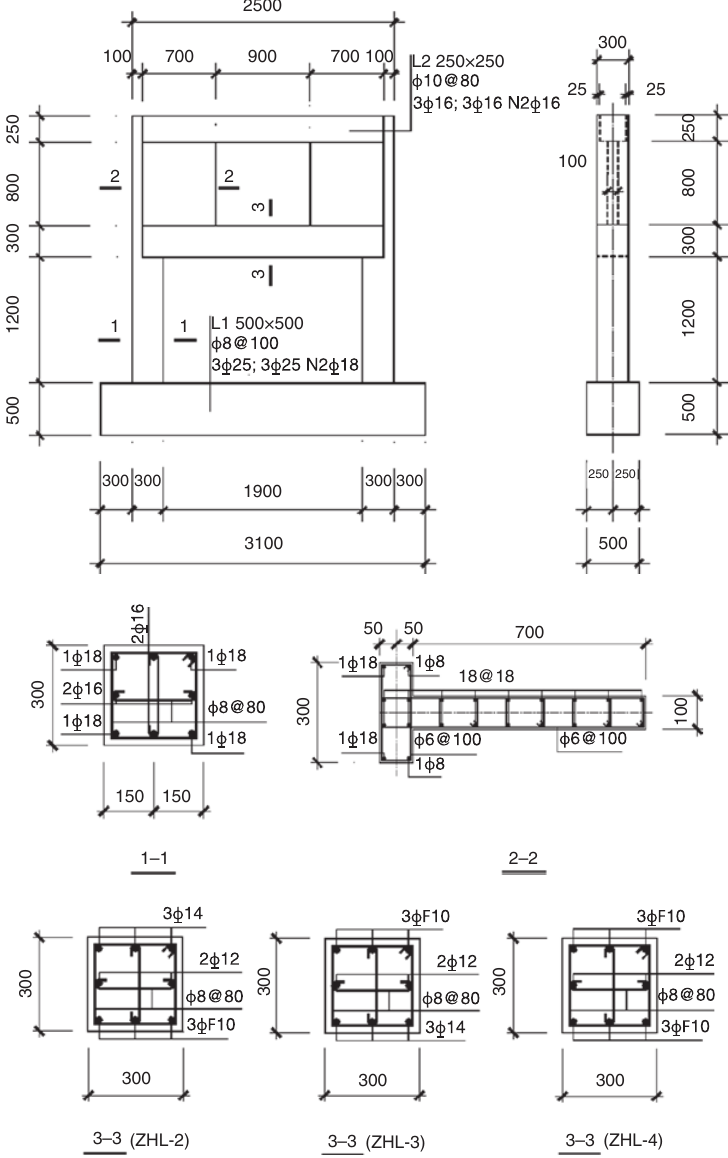
Figure 1: Specimen details (components scale and reinforcement detailing). F was designated for CFRP bars.